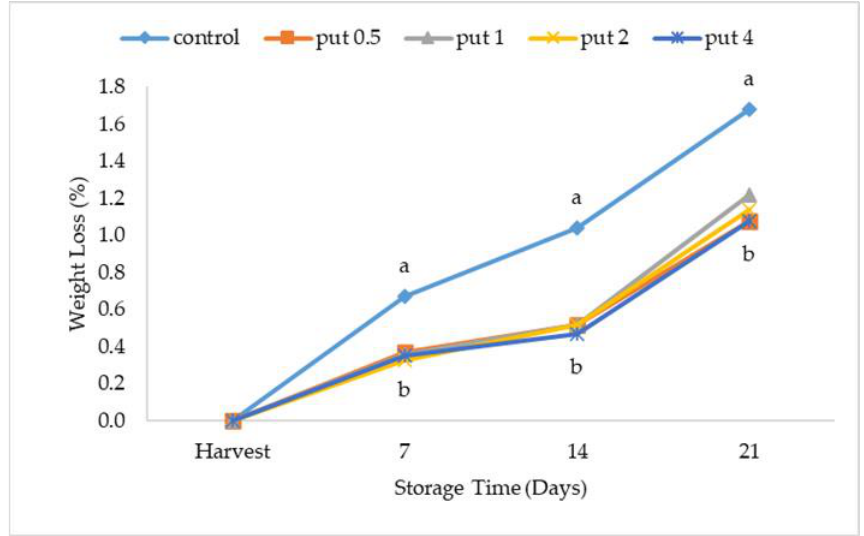
Figure 1. Effect of putrescine treatment on weight loss of fig fruit during cold storage. Put 0.5, 1, 2 and 4 indicates putrescine doses of 0.5 mM, 1 mM, 2 mM, and 4 mM, respectively. According to the Tukey test, p < 0.05 does not differ between the same letters in the same harvest period.